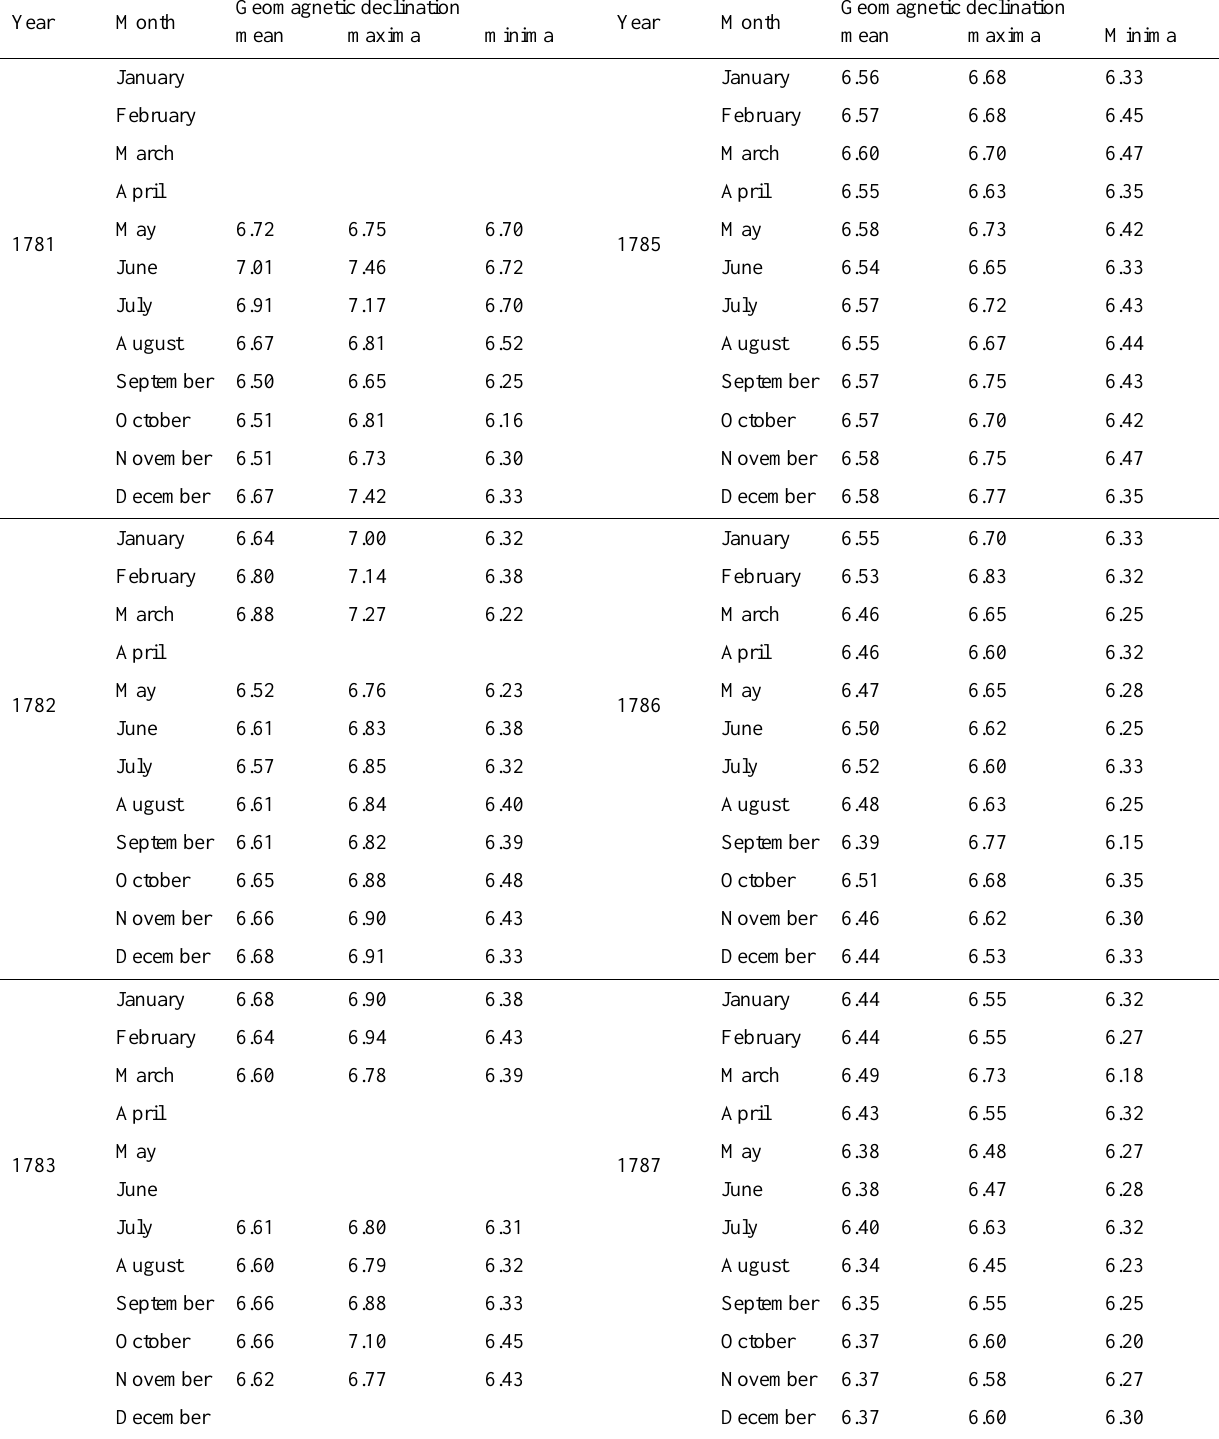
Table 2. Monthly average values (mean, maxima and minima) of geomagnetic declination in Rio de Janeiro between May 1781 and May 1788. All values in